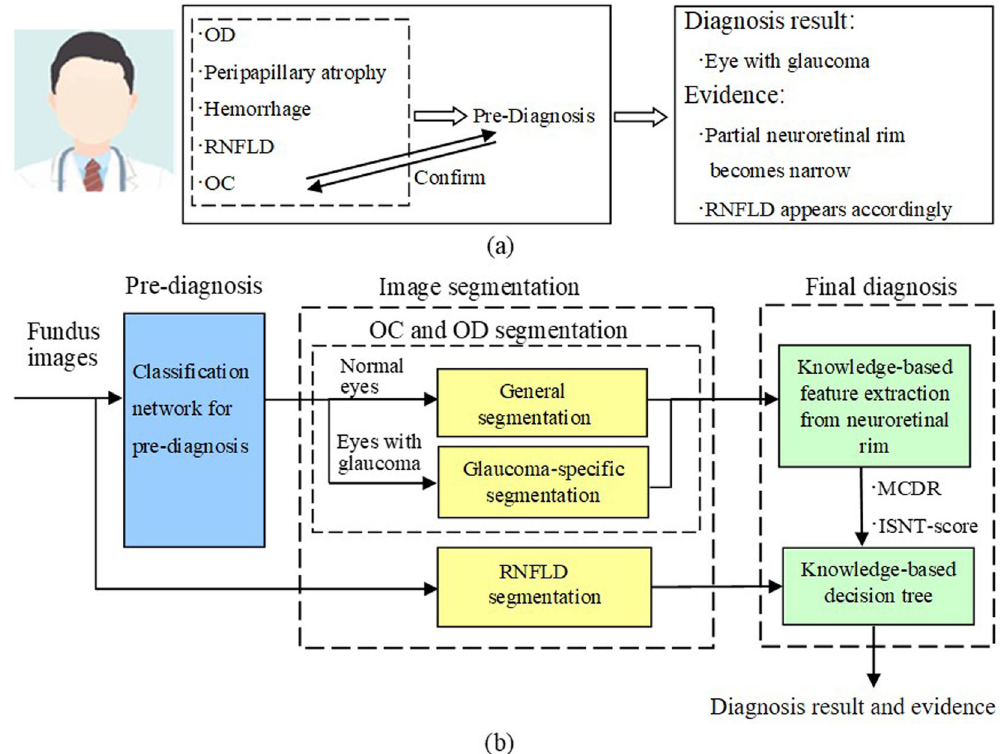
Fig. 1 Schematic diagram of the hierarchical deep learning system (HDLS) simulating doctors ’ diagnostic thinking. a The process of doctors ’ diagnosis of glaucoma. b The process of diagnosing glaucoma of the HDLS. This system includes three modules: The pre-diagnosis module is used for preliminary diagnosis based on the overall information of the fundus photographs. The image segmentation module is used to segment OD, OC, and RNFLD based on the pre-diagnostic results. For fundus photographs pre-diagnosed as glaucoma, a glaucoma- speci fi c network is used to segment the OC. The fi nal diagnosis module is used to calculate MCDR and ISNT-score based on the segmentation. Finally, these two indicators are used to make a fi nal diagnosis in combination with the status of RNFLD. OD optic disc, OC optic cup, RNFLD retinal nerve fi ber layer defects, MCDR mean cup-to-disk ratio, ISNT inferior, superior, nasal,